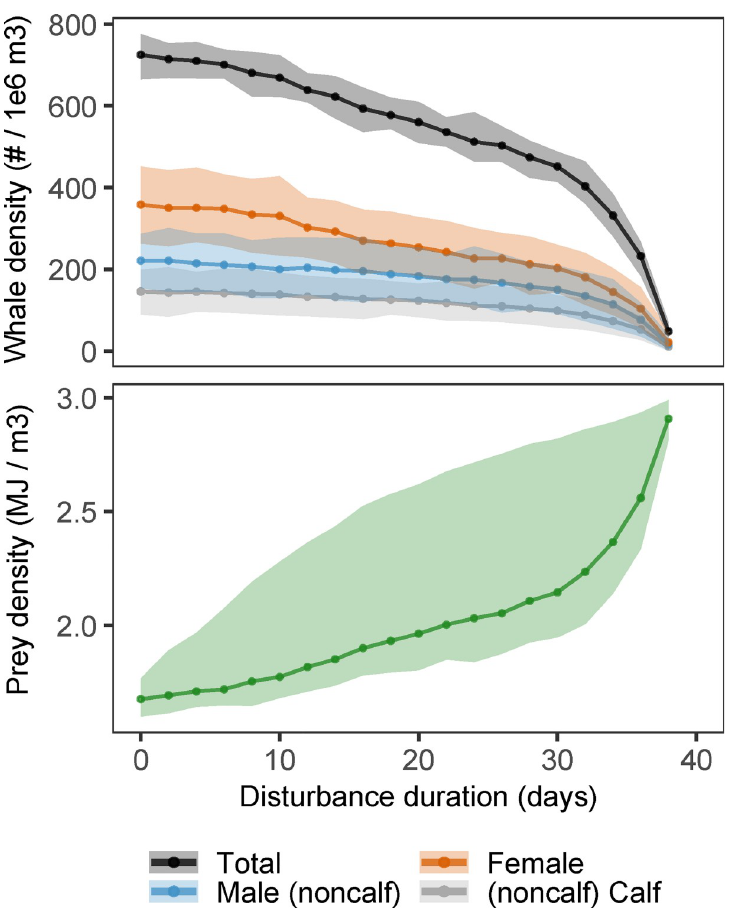
Fig 3. Effect of disturbance duration on population density. Whale (top panel) and prey density (bottom panel) in the stationary population as a function of disturbance duration ( t of 200 simulated years, after an initial 200-year period to allow the population to reach its stationary state. Output was collected every 5 days (14600 observation per point). Lines connect mean densities and shaded areas indicate min/max